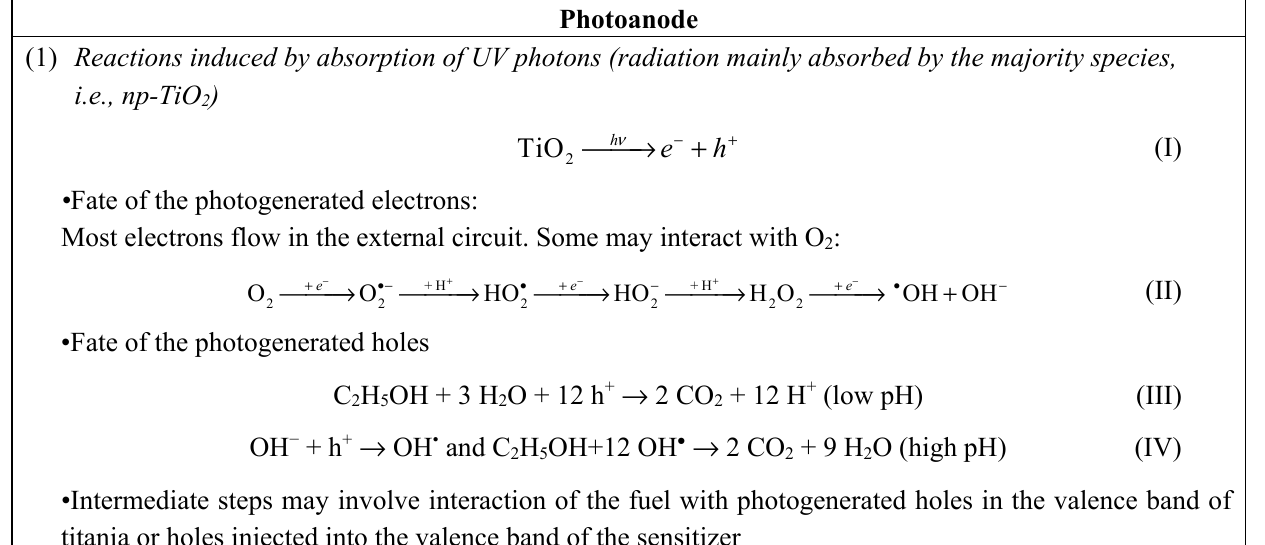
Table 1. Typical reactions taking place in a PFC employing ethanol as model fuel.